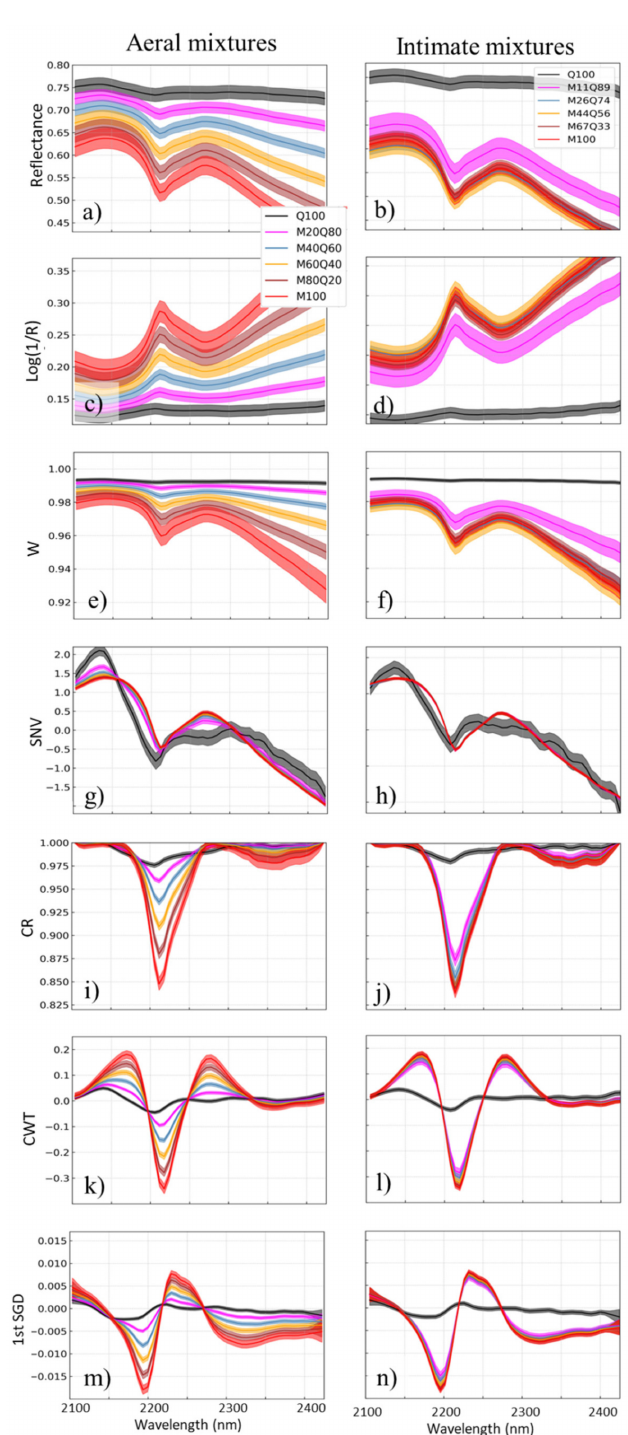
Figure 8. Montmorillonite–quartz: from ( a ) to ( b ) reflectance spectra and from ( c ) to ( n ) application of the 6 spectral preprocessings from aeral mixtures (first column), intimate mixture (second column; line: mean reflectance, ribbon: mean ± one standard